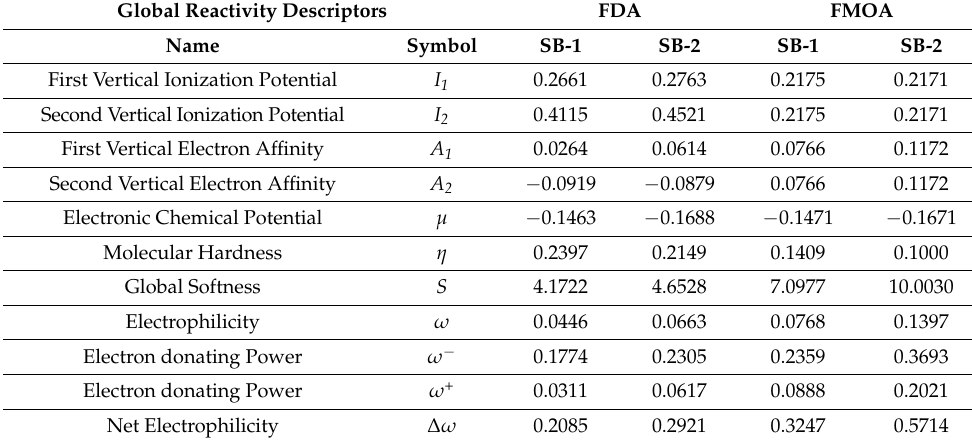
Table 1. Some global reactivity descriptors and SB-1, SB-2, and precursors for SB-1 were obtained from the B3LYP/6-311++G(d,p) level of